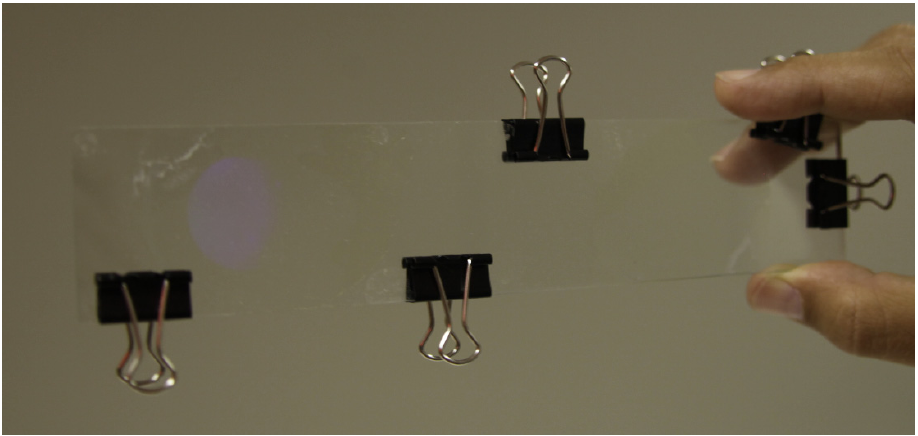
Figure 7. Photography of the recorded waveguide.